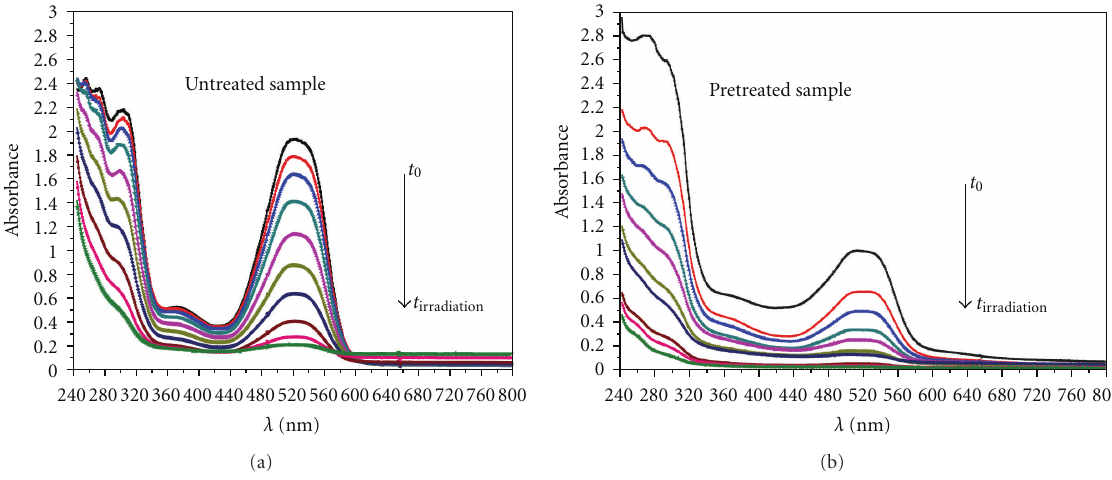
Figure 5: Temporal changes in absorption spectra of untreated (a) and pretreated (b) Reactive red 22 textile e ffl uent taken at 5–15 min intervals, the irradiation time was 210